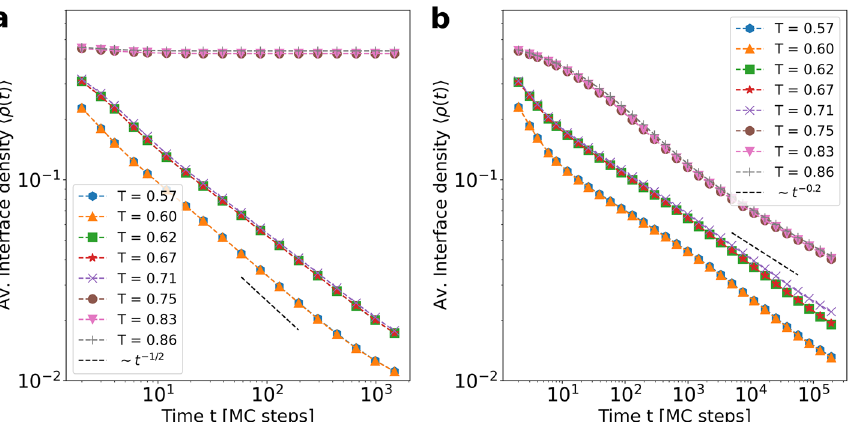
ρ( t ) Figure 3. Average interface density as a function of time steps for different values of the tolerance (cid:31) (cid:30) parameter T using the Schelling model ( a ) and the version with aging ( b ). Average performed over 5 realizations. Fitted power-law in a black dashed line highlighting the estimated exponent value. We set system 200 and ρ v 0.005 size L = =